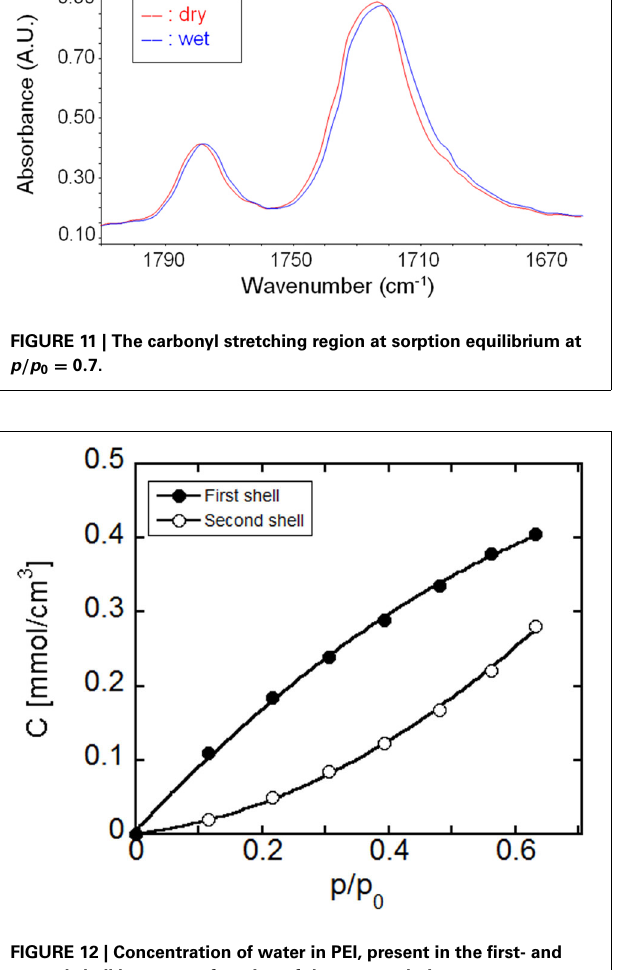
FIGURE 12 | Concentration of water in PEI, present in the first- and second shell layers as a function of the water relative vapor pressure. Curves connecting the data points are to be intended for eye guidance